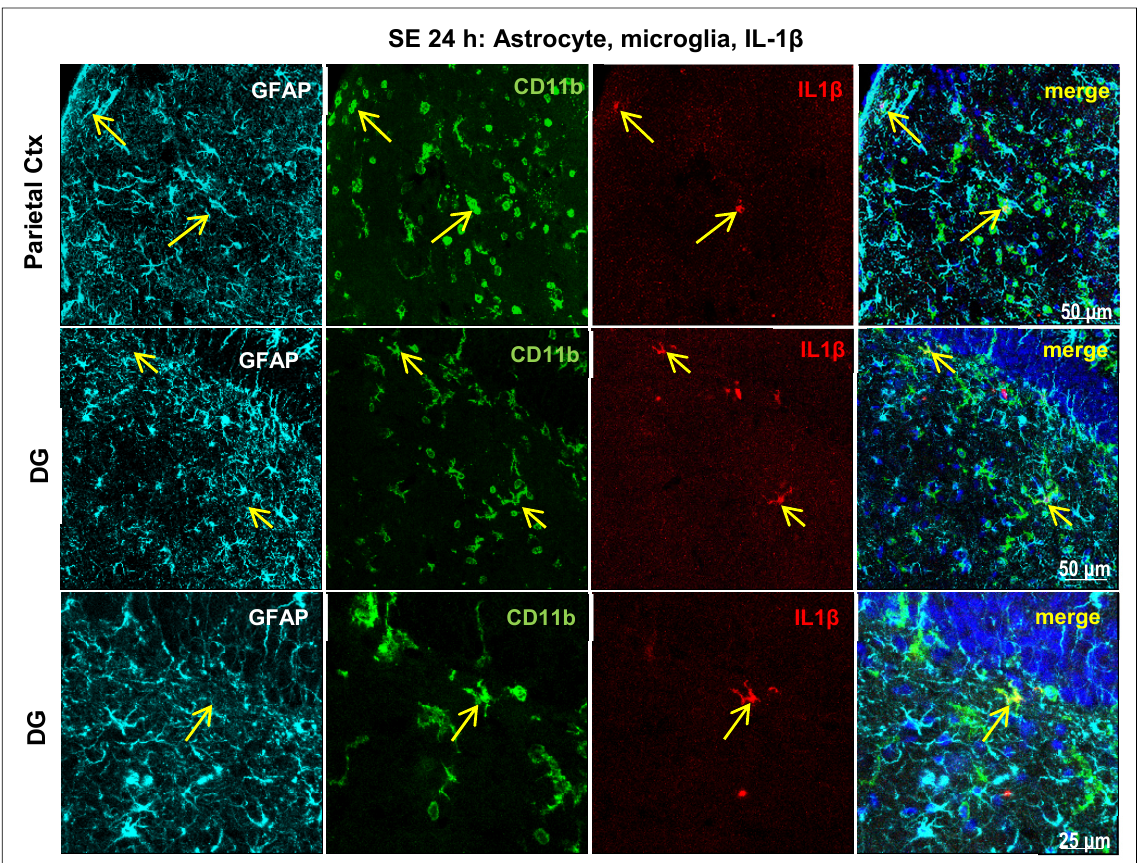
Figure 4. Fluorescent labeling of astrocytes (immunostaining of glial fibrillary acidic protein, GFAP), microglia (immunostaining of CD11b and IL-1 β ), and cellular nuclei (DAPI staining, in blue) in the parietal cortex (Ctx) and dentate gyrus (DG) 24 h after the onset of pilocarpine-induced seizures lasting 3 h. Merge images show the colocalization of IL-1 β immunosignal with microglial elements (yellow arrows) in both regions, whereas no IL-1 β immunopositivity is found in the astrocytes. Two different sections of DG at different magnifications are shown.